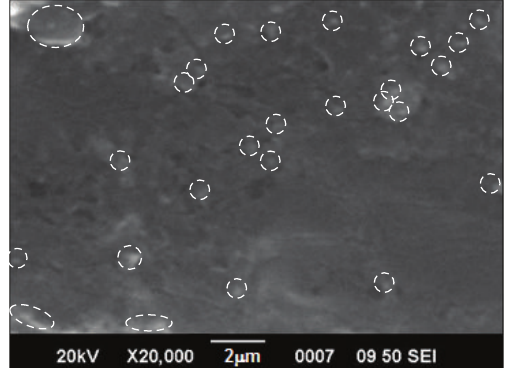
Figure 3: SEM image of epoxy-titania composite films with 5 wt.% titania particles (ET-5).